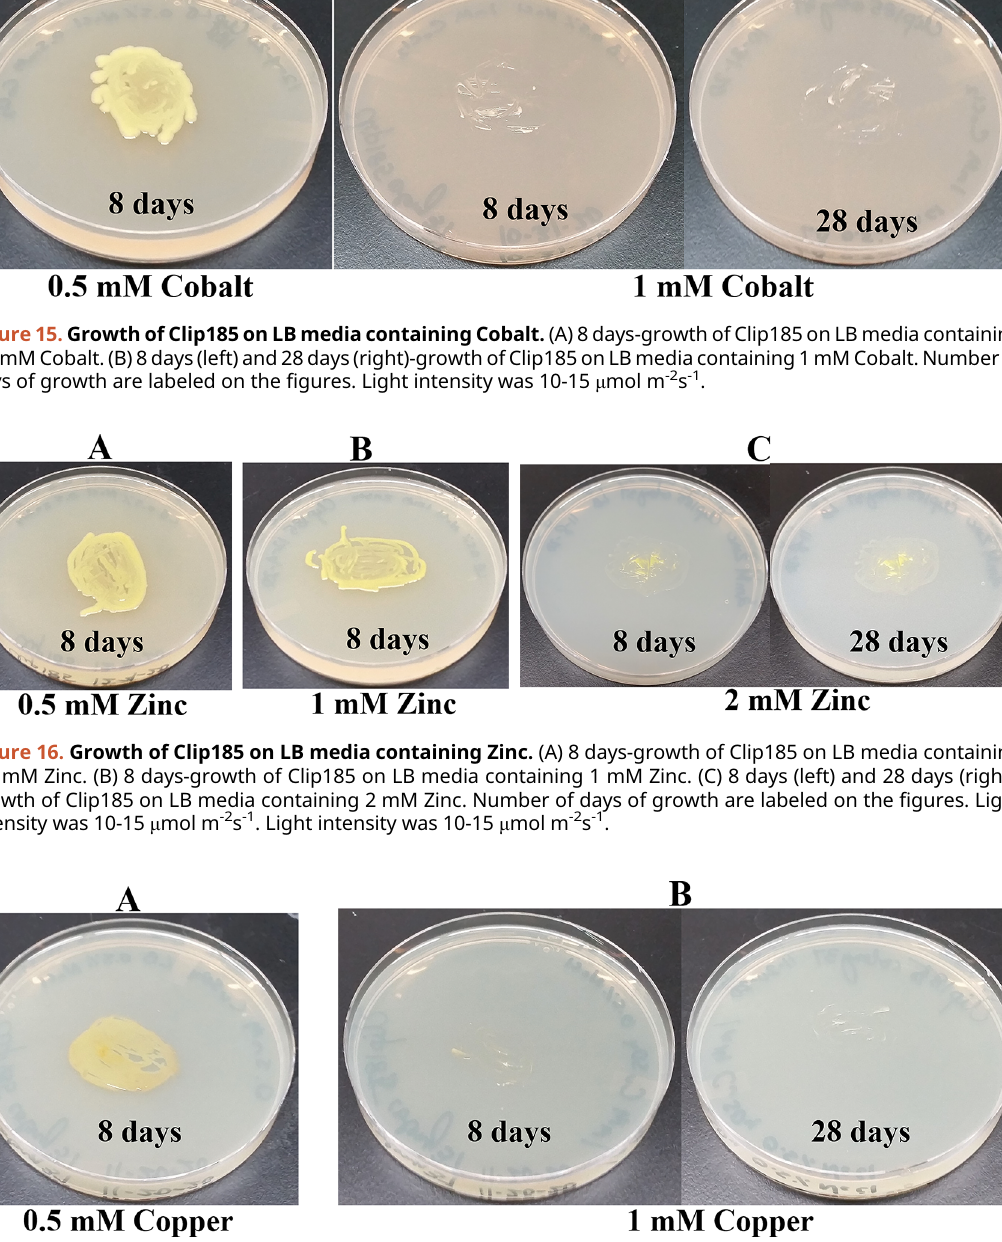
Figure17.GrowthofClip185onLBmediacontainingCopper. (A)8days-growthofClip185onLBmediacontaining 0.5mM Copper. (B) 8 days (left) and 28 days (right)-growth of Clip185 on LBmedia containing 1 mM Copper. Number of days of growth are labeled on the figures. Light intensity was 10-15 μ mol m -2 s -1